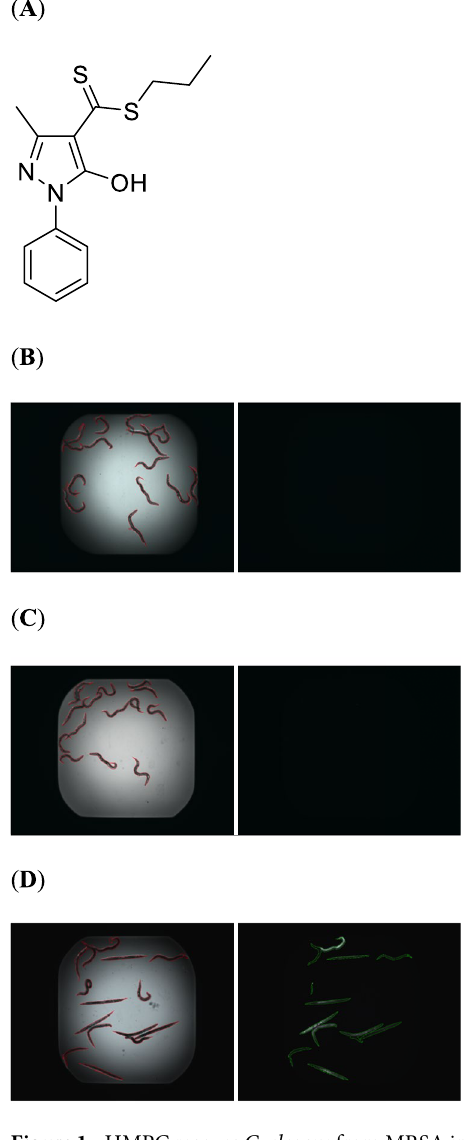
Figure 1. HMPC rescues C. elegans from MRSA infection. ( A ) Chemical structure of propyl 5-hydroxy-3- methyl-1-phenyl-1 H -pyrazole-4-carbodithioate (HMPC). ( B–D ) Results of compound screening for C. elegans viability following S. aureus MW2 infection. A 384-well assay plate was co-inoculated with C. elegans , S. aureus MW2 and either 7 μ g/ml HMPC ( B) ; 100% survival), 10 μ g/ml vancomycin ( C ) positive control; 100% survival), or 1% DMSO vehicle ( D ) negative control; 40% survival). Representative Sytox Orange-stained (right) and bright field (left) images from assay wells are shown. Only dead worms take up Sytox Orange and fluoresce. The images were first captured with an ImageExpress and further processed with CellProfiler to normalize the fluorescent or bright field intensity and to define the area of each